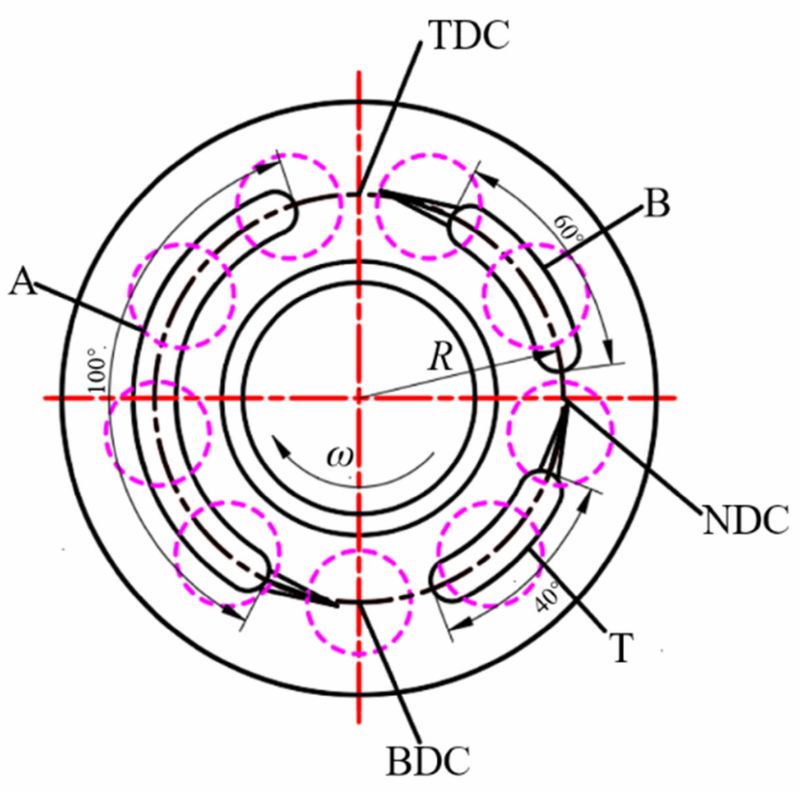
Figure 2. Schematic diagram of the distribution